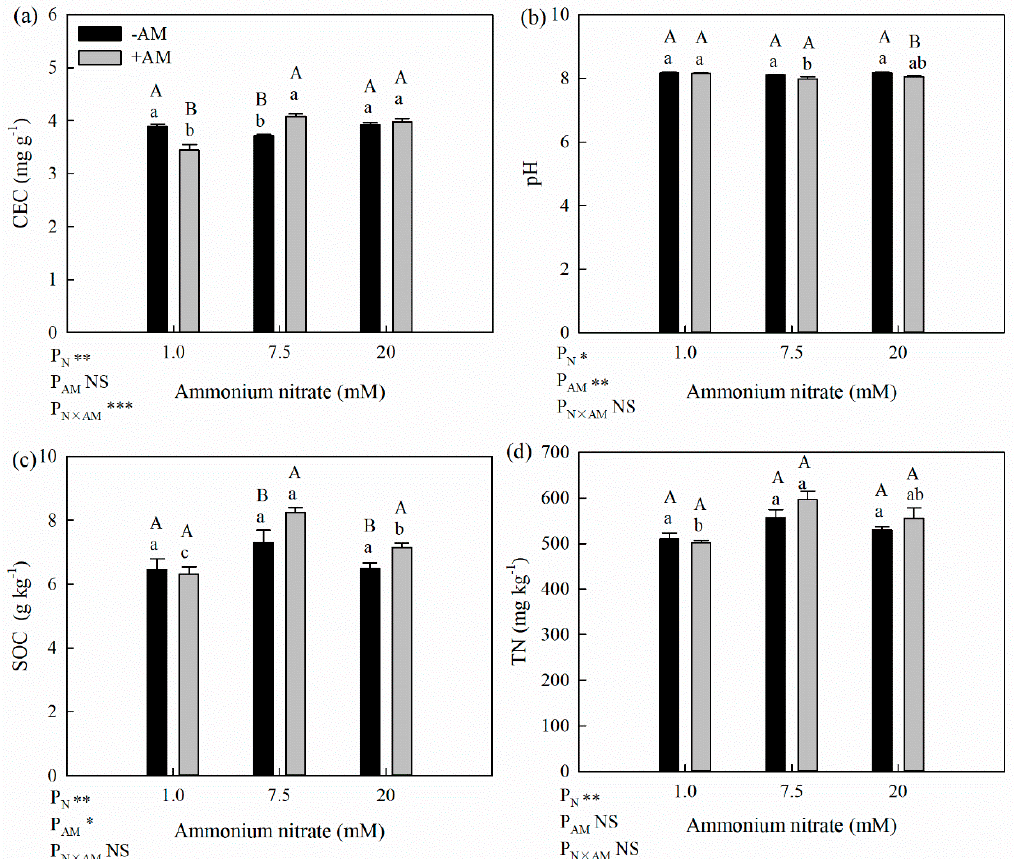
Figure 4. E ff ects of AM fungi on soil properties at di ff erent N levels ( a . cation exchange capacity (CEC); Figure 4. Effects of AM fungi on soil properties at different N levels (a. cation exchange capacity b . pH; c . soil organic carbon (SOC); d . total N (TN)). * significant e ff ect at p < 0.05; ** significant e ff ect (CEC); b. pH; c. soil organic carbon (SOC); d. total N (TN)). *significant effect at p < 0.05; **significant at p < 0.01; *** significant e ff ect at p < 0.001; NS: no significant e ff ect. Values are presented as the means effect at p < 0.01; ***significant effect at p < 0.001; NS: no significant effect. Values are presented as the ± SE ( n = 3). Di ff erent lowercase letters indicate significant di ff erence among di ff erent N levels with the means ± SE ( n = 3). Different lowercase letters indicate significant difference among different N levels same AM treatment and di ff erent uppercase letters indicate significant di ff erence between + AM and with the same AM treatment and different uppercase letters indicate significant difference between − AM treatments under the same N level at p < +AM and − AM treatments under the same N level at p < 0.05.